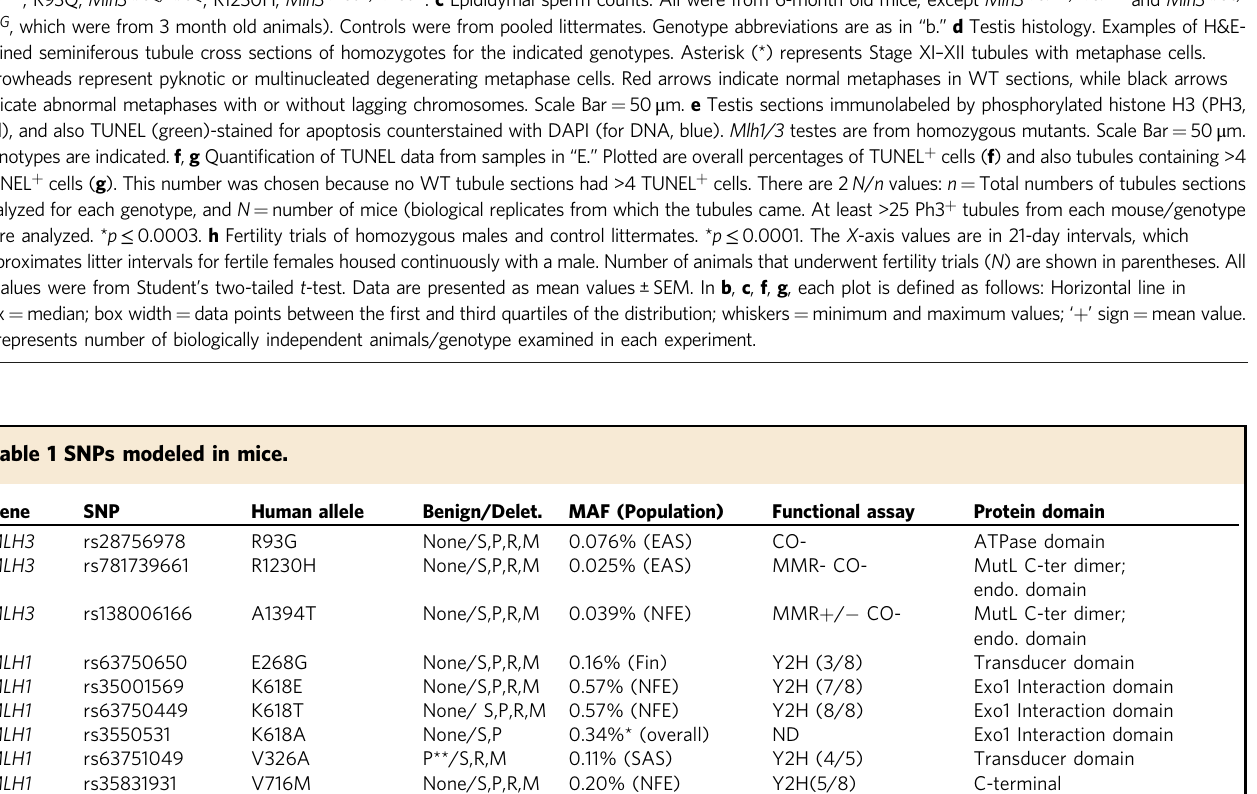
and K618T, which almost always co-occur (see text). For functional assays in yeast, see details in Table S2. **This pathogenicity score is classi fi ed as “ possibly ” damaging.